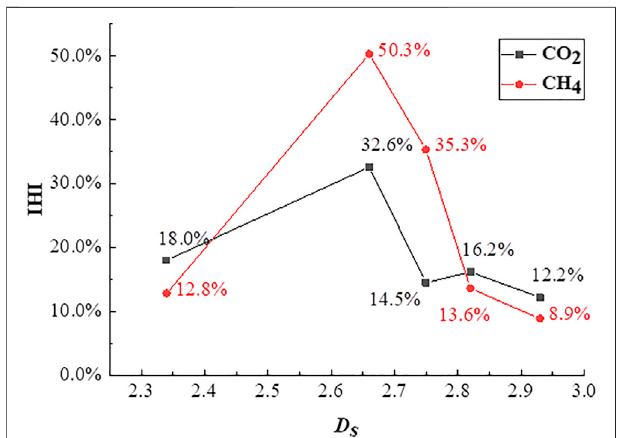
FIGURE 7 | D s vs. IHI